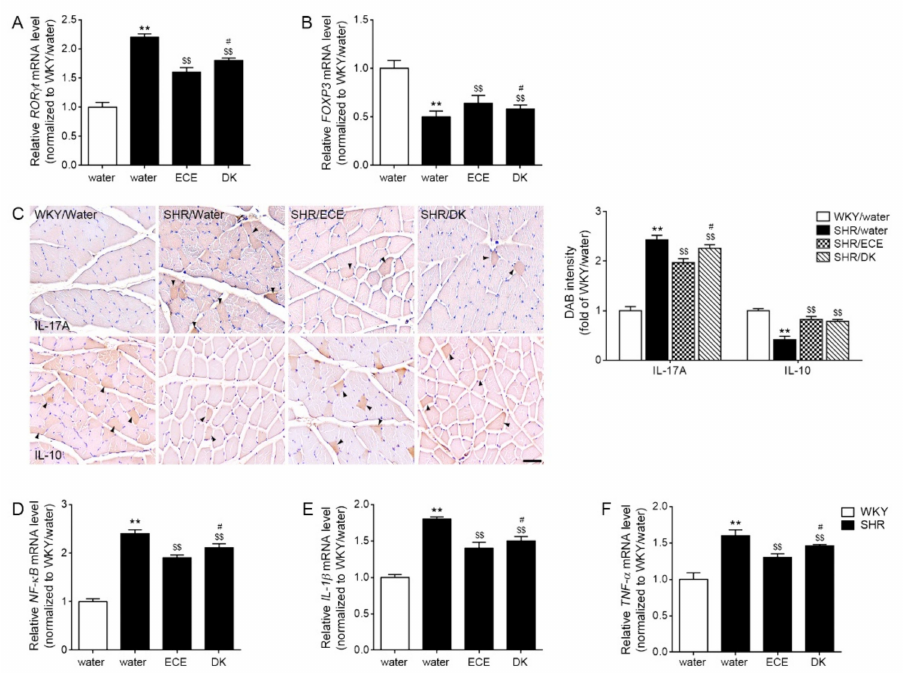
Figure 3. Regulatory effects of ECE and DK on decreasing factors related with Th17 differentiation and inflammatory cytokines in the muscle of SHRs. ( A ) The expression levels of ROR γ t in muscle were increased following SHR/water and decreased following ECE or DK treatment. ( B ) The expression levels of FOXP3 in muscle were decreased following SHR/water and increased following ECE or DK treatment. ( C ) The intensity of IL-17A in muscle was increased following SHR/water and decreased following ECE or DK treatment via immunohistochemistry. However, the intensity of IL-10 in muscle was decreased following SHR/water and increased following ECE or DK treatment. ( D – F ) The expression of NF- κ B ( D ), IL-1 β ( E ), and TNF- α ( F ) mRNA levels in muscle was increased following SHR/water and decreased following ECE or DK treatment. The mRNA levels were measured using qRT-PCR, normalized versus actb , and expressed relative to the WKY/water group levels. Data are presented as mean ± SD. For each of the 4 groups. n = 5. **, p < 0.01, vs. WKY/water; $$, p < 0.01, vs. SHR/water; #, p < 0.05, vs. SHR/ECE (Mann–Whitney U test). DK, dieckol; ECE, Ecklonia cava extract; FOXP3, forkhead box P3; IL-1 β , interleukin-1beta; IL-10, interleukin-10; IL-17A, interleukin-17A; NF- κ B, nuclear factor kappa-light-chain-enhancer of activated B cells; ROR γ t, retinoic-acid-receptor-related orphan nuclear receptor gamma t; SHR, spontaneously hypertensive rat; TNF- α , tumor necrosis factor-alpha; WKY, Wistar Kyoto